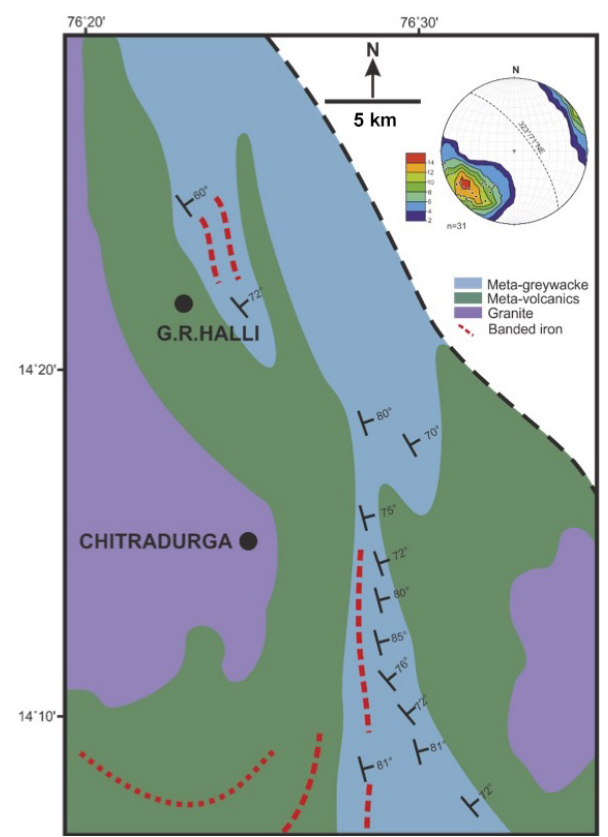
Figure 2. Geological map of the study area showing the foliation trends of the supracrustals. Lower hemisphere equal area projection shows the pole to foliation planes recorded from the region. Note that the mean foliation (dotted great circle) is 323/71 ◦ NE, which is parallel to the CSZ ( n : number of data). Color scheme of the legend indicates variation in the contour